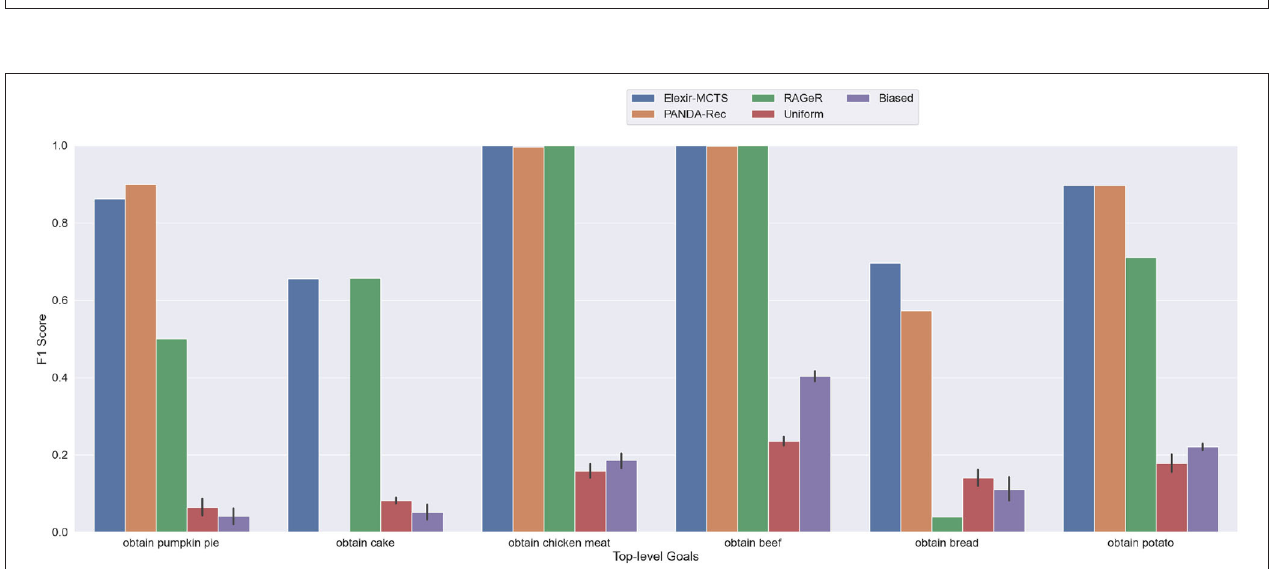
FIGURE 6 | Performance of PANDA-Rec, Elexir-MCTS, RAGeR, and two baselines (Random Uniform and Random Biased Recognition) over the medium-inspectability Minecraft traces . Metric shown in the figure is the F1 score for each top-level goal in the Minecraft domain. Random Uniform and Random Biased bars are calculated for each top-level goal by taking the average F1 score over 10 runs.